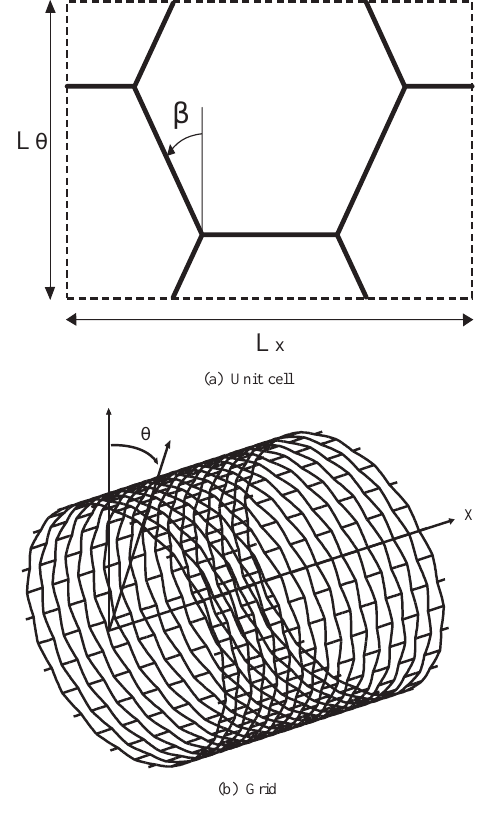
Fig. 2. Hexagonal cell and